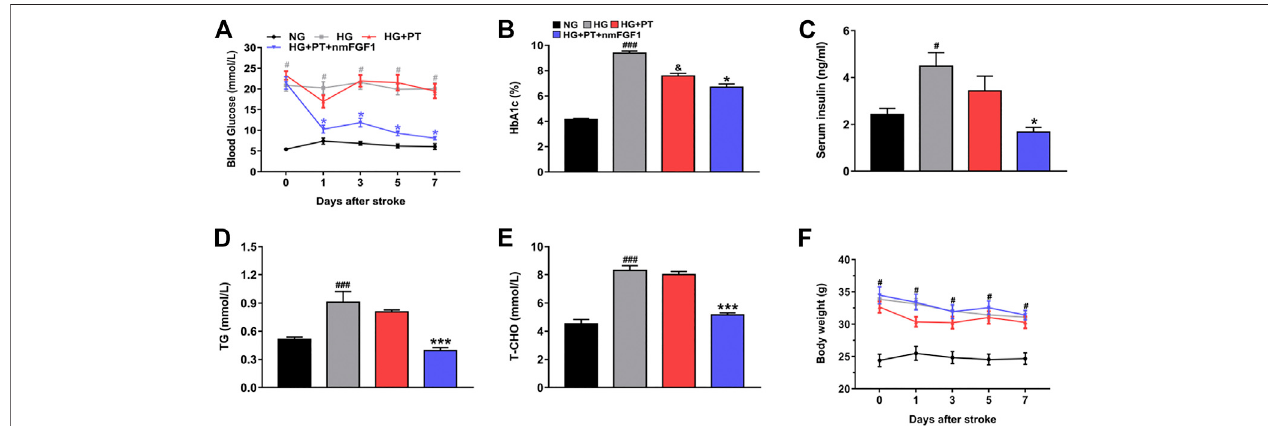
FIGURE 7 | NmFGF1 ameliorated disorders of glucose and lipid metabolism in a mouse model of type 2 diabetic stroke. (A) Changes of blood glucose in diabetic micewerecontinuouslymonitoredfor7daysafterstroke(n (cid:2) 8). (B – E) TheeffectsofnmFGF1onthelevelsofHbA1c,insulin,triglycerides,andtotalcholesterol,onday7 after ischemic stroke (n (cid:2) 6). (F) The changes of body weight in diabetic mice were continuously monitored for 7 days after stroke (n (cid:2) 8). Data are presented as mean ± SEM. # p < 0.05, ### p < 0.001 vs. NG group; & p < 0.05 vs. HG group; * p < 0.05, *** p < 0.001 vs. HG + PT